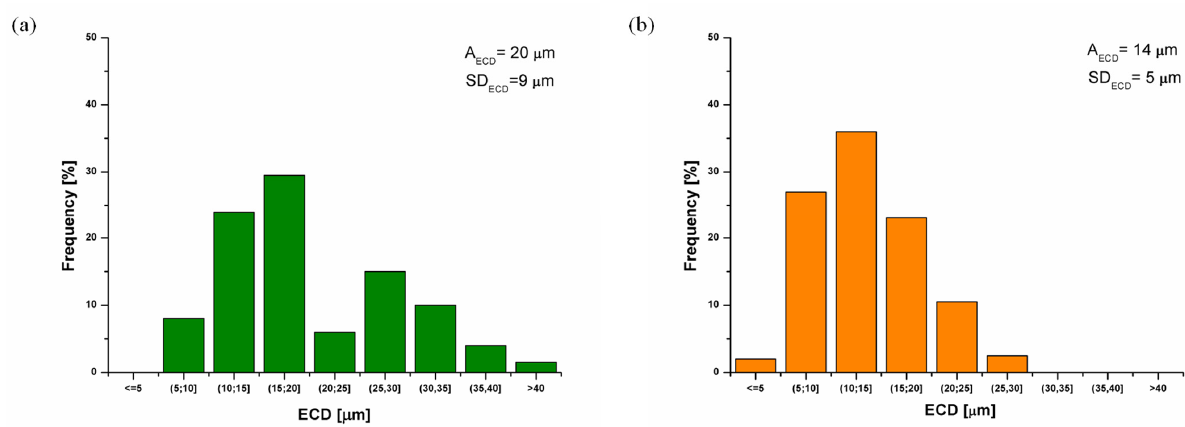
Figure 4. Influence of frequency of cyclic loading on the size and the dimensional homogeneity of the FeAl alloy pre-sintered at 620 °C: ( a ) 20 Hz; ( b ) 40 Hz.